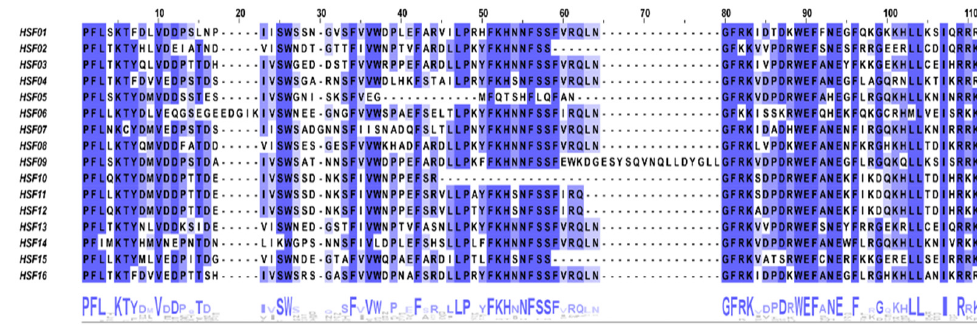
Figure 3. Three-dimensional model of the protein of MsHSF family members, with the starting po- sition of the α 1 DBD structural domain indicated by 1. A–P in the figure represent the 16 proteins of the M. sativa HSF family, respectively. 2.4. Gene Structure and Conserved Motif Analysis of the HSF Gene in M. sativa HSF proteins were split into three categories, HSF A, HSF B, and HSF C, based on the phylogenetic analyses mentioned above (Figure 4A). Our analysis of the MsHSF gene struc- ture revealed that HSF genes from the same group typically have a similar number of